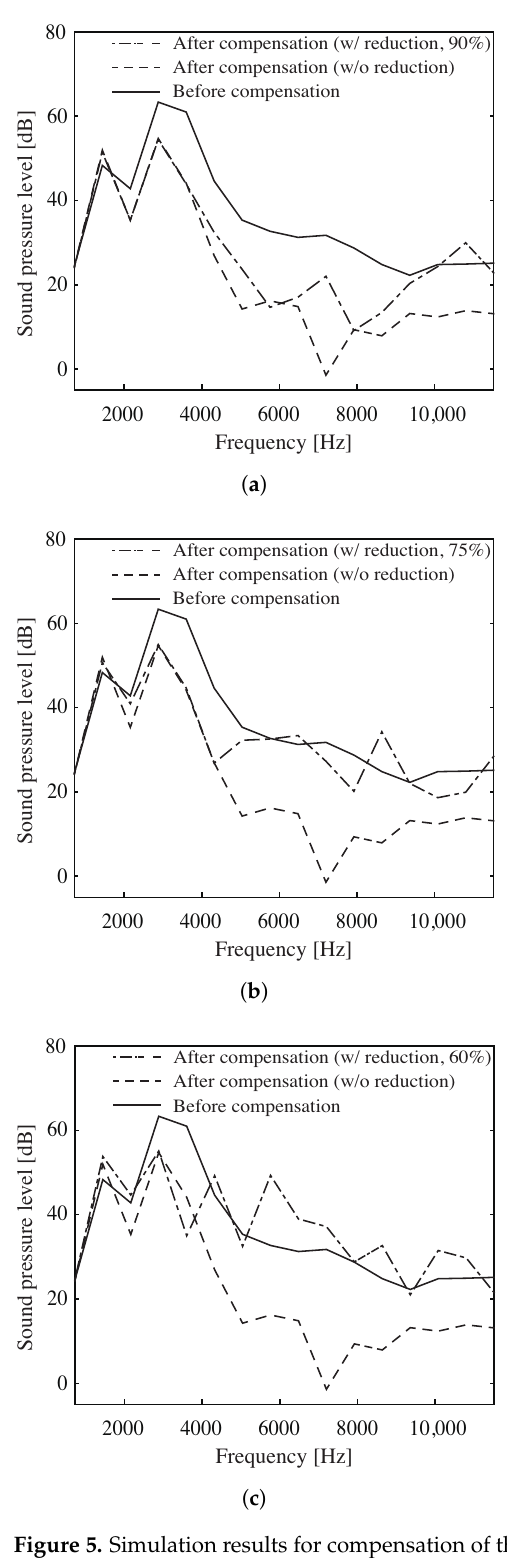
Figure 5. Simulation results for compensation of third-order harmonic distortion. ( a ) Reduction rate r = 60%. ( b ) Reduction rate r = 75%. ( c ) Reduction rate r =